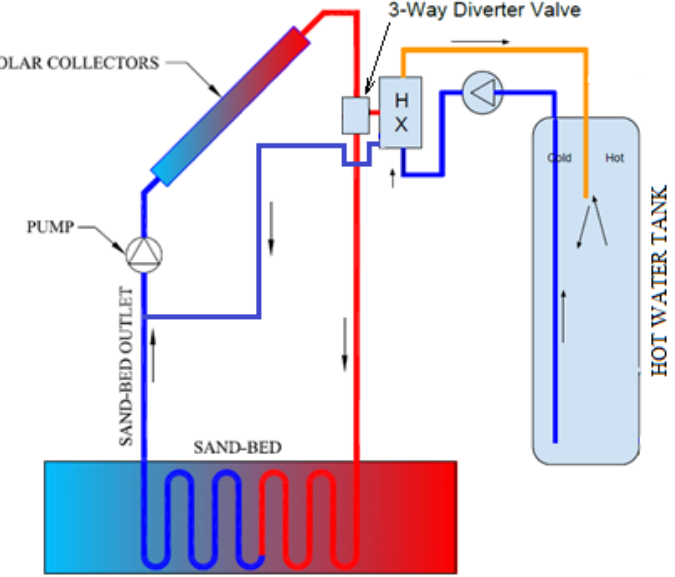
Figure 3. Schematic of the evacuated tube solar collectors and the thermal storage.